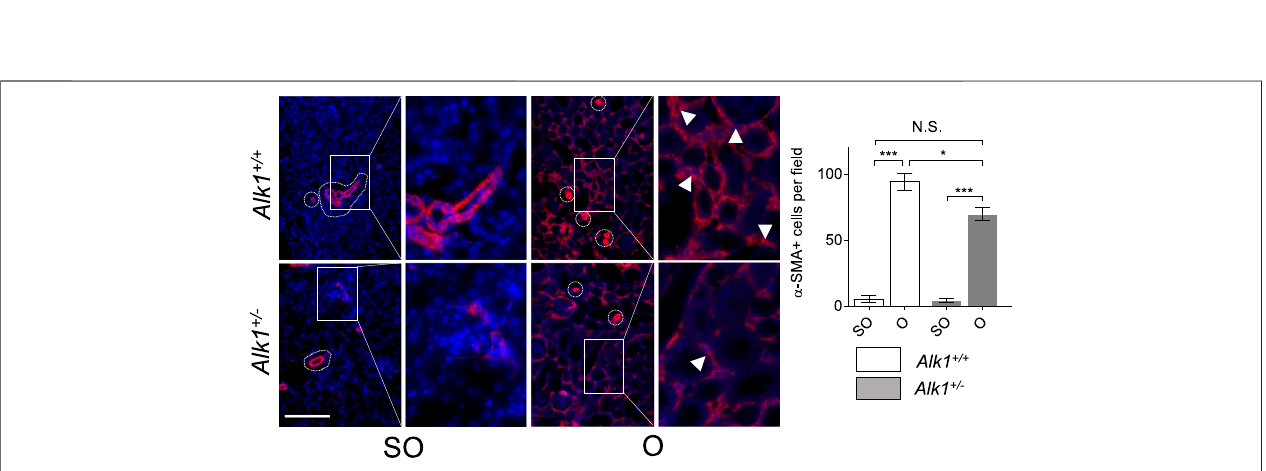
FIGURE 5 | Analysis of α -SMA + myo fi broblasts. Identi fi cation of α -SMA+ myo fi broblasts by immuno fl uorescence of α -SMA with Hoechst counterstaining in SO and O kidneys from Alk1 +/+ and Alk1 +/ − mice. Squares identify zoomed areas * p < 0.05; *** p < 0.001; N.S = Not statistically signi fi cant. (Two-way ANOVA). Cropped areas identify α -SMA+ VSMCs from small vessels. Arrowheads identify α -SMA+ tubulo-interstitial myo fi broblasts. Scale bar = 150 microns.